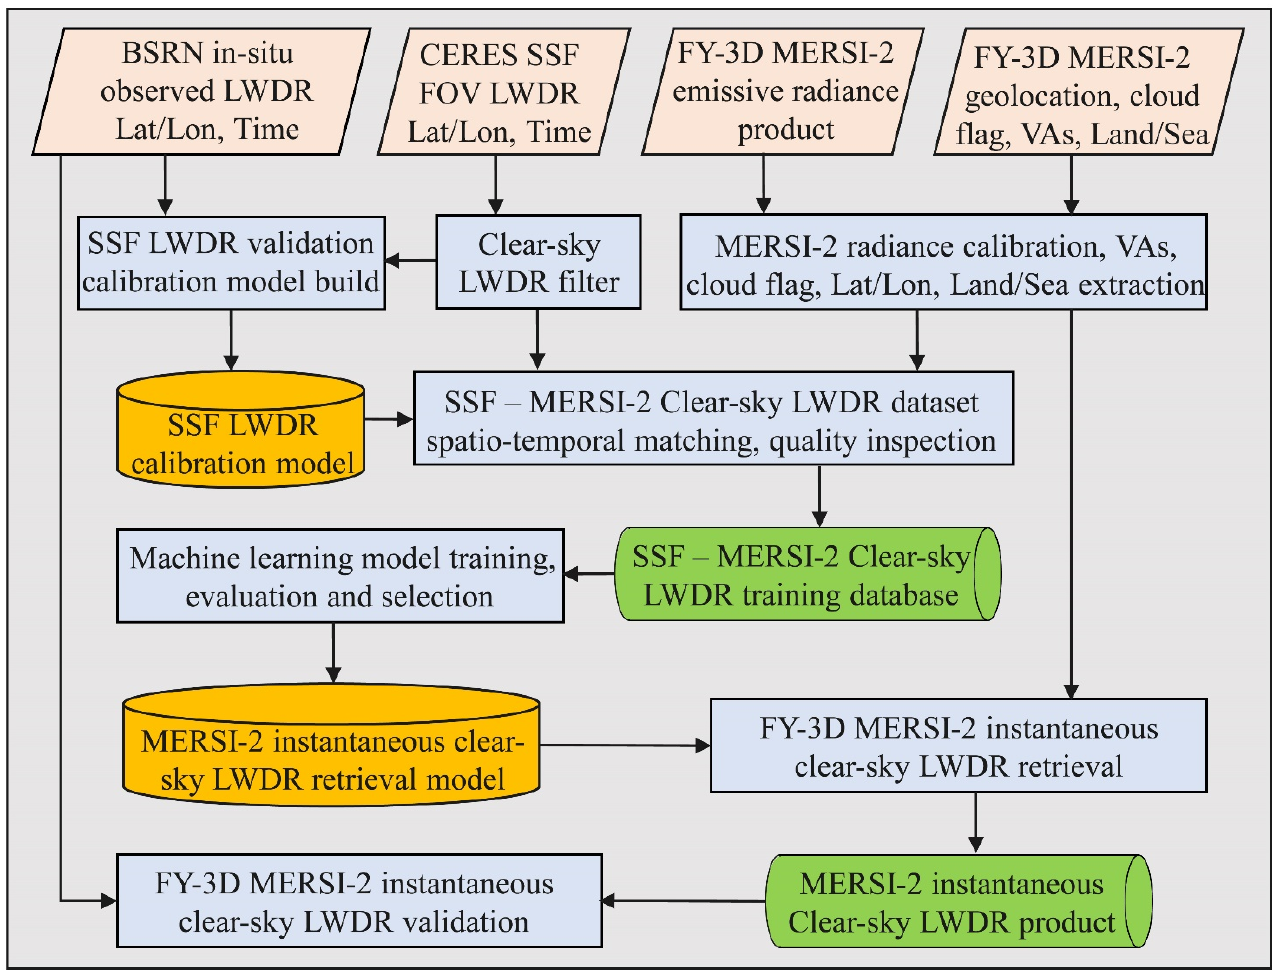
Figure 1. Flowchart of this study for estimating clear-sky LWDR from FY-3D MERSI-2 data using ML techniques.